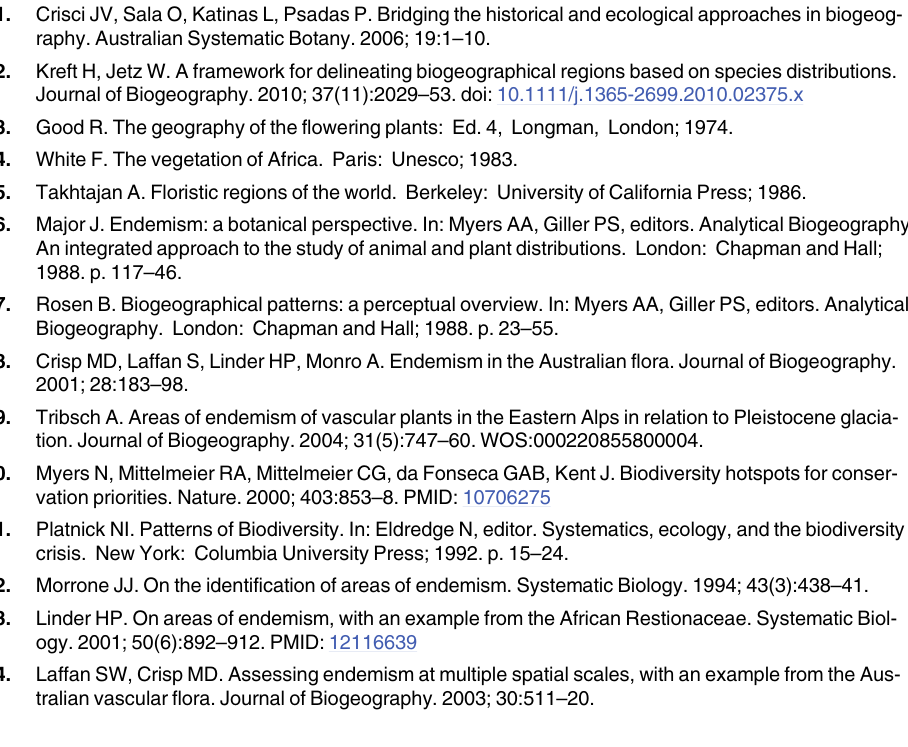
S4 Table. The complete list of CoEs and Sub-CoEs and their properties retrieved in the study. As the dataset was biased to Cape clades ( sensu Linder, 2003), interpretation of extra- CFR CoE should be limited to where potential extra-Cape CoEs for Cape taxa might be located, as the dataset examined does not comprise the entire compliment of Cape Clades. Further, interpretation of national CoEs in a national context would require a floristically unbiased national dataset. To be used in conjunction with S2